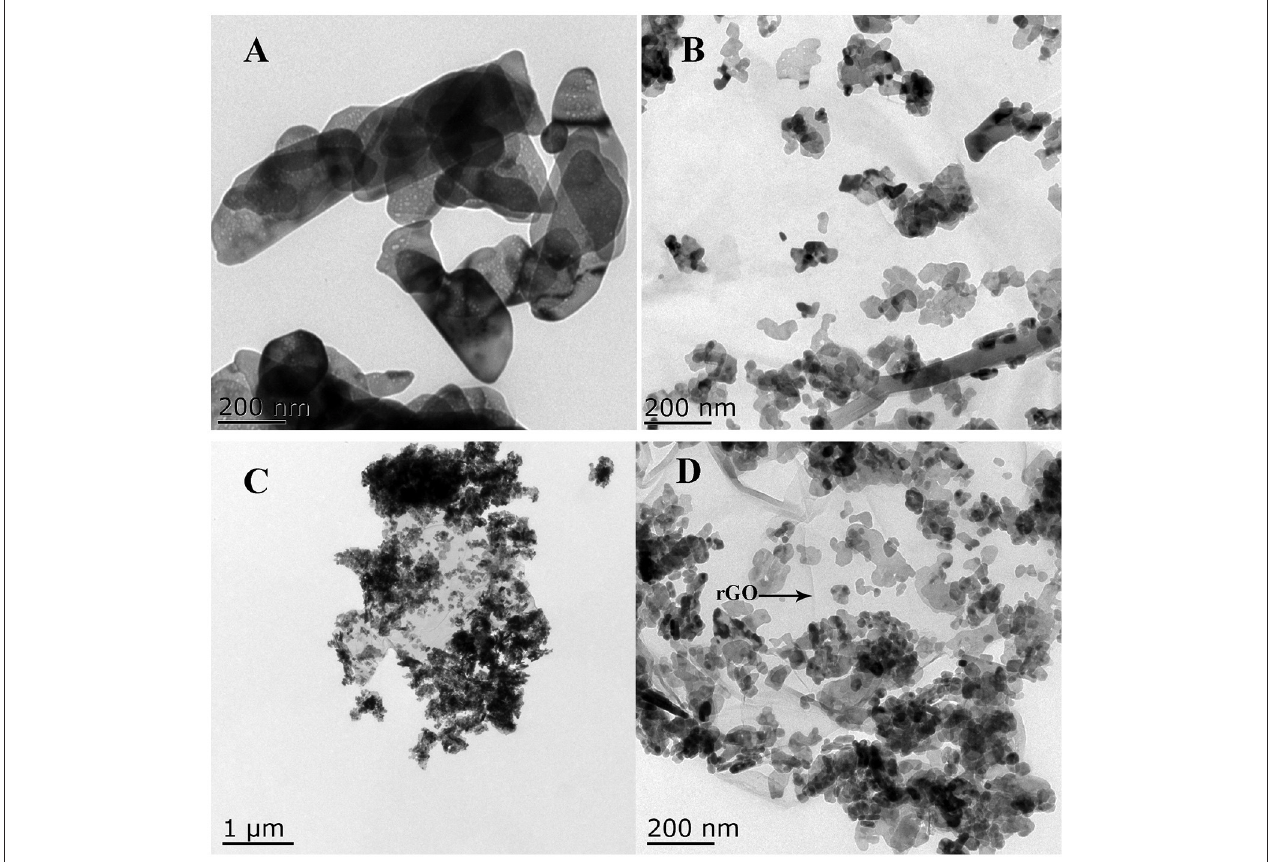
FIGURE 2 | TEM images of (A) ZnO, (B) Cu/ZnO, (C) Cu/ZnO/rGO, and (D) enlarged image of Cu/ZnO/rGO.